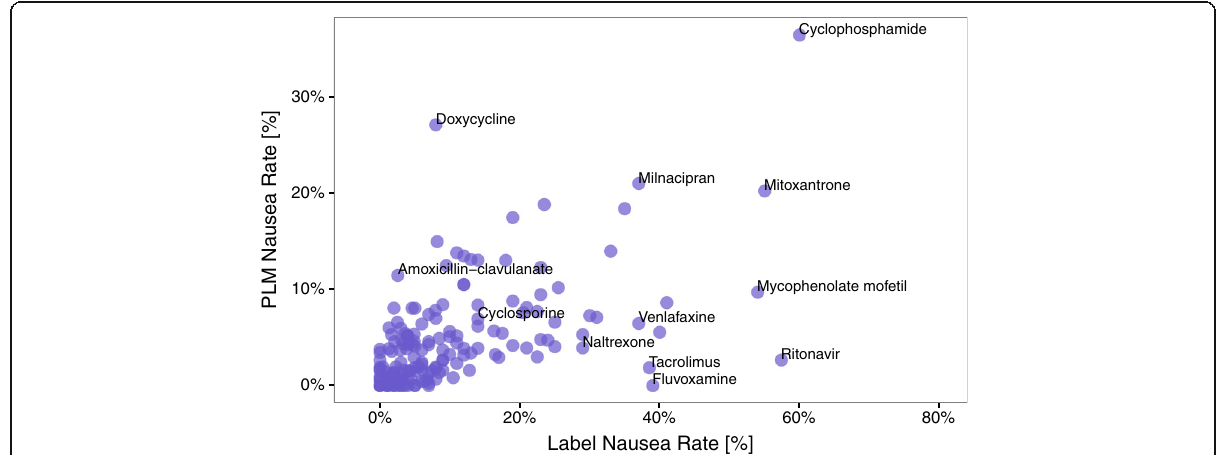
Fig. 3 PatientsLikeMe nausea rates versus medication label nausea rates. Selected medications are highlighted with text labels